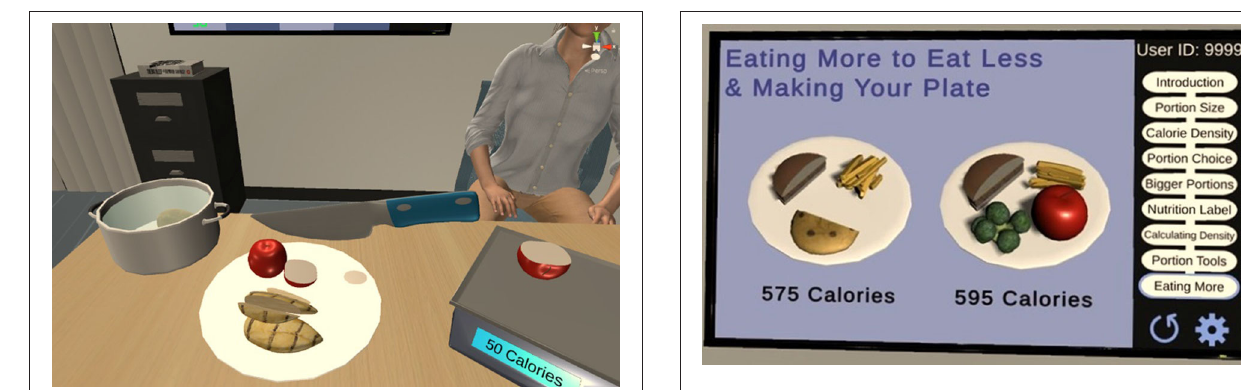
FIGURE 4 | Comparison of the assembled dishes based on their calorie